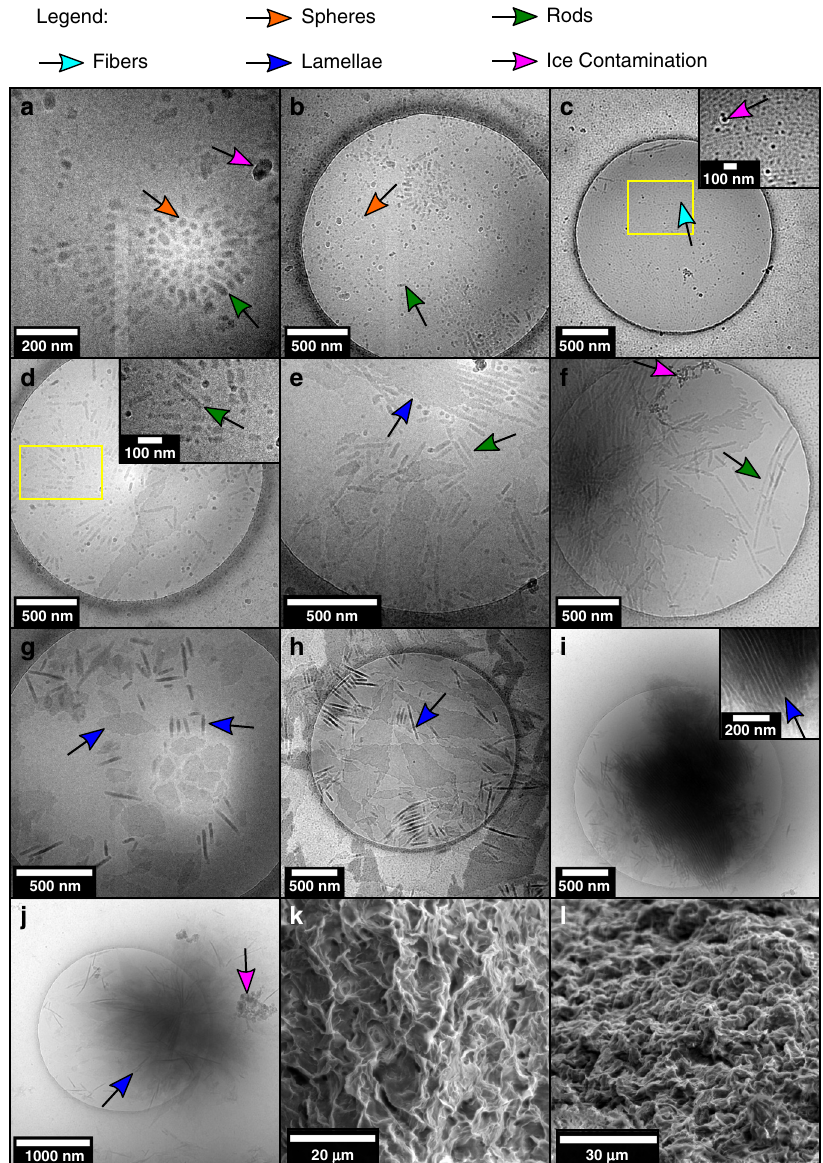
Fig. 4 Representative images of ROPI-CDSA morphologies. Selected cryo-TEM ( a – j ) and SEM ( k – l ) images for representative morphologies of the phase diagram, a – c is for 1D systems, d – h are for 2D systems, i – l are for 3D systems. Images are from the following samples: a , b: 7 , c: 5 , d , e: 9 , f: 6 , g , h: 13 , i : 16 , j: 19 , k , l : 17 . (See Table 1 for a sample guide). The data show that ROPI-CDSA can be used to form block copolymer materials with a wide range of morphologies, dimensions, and length